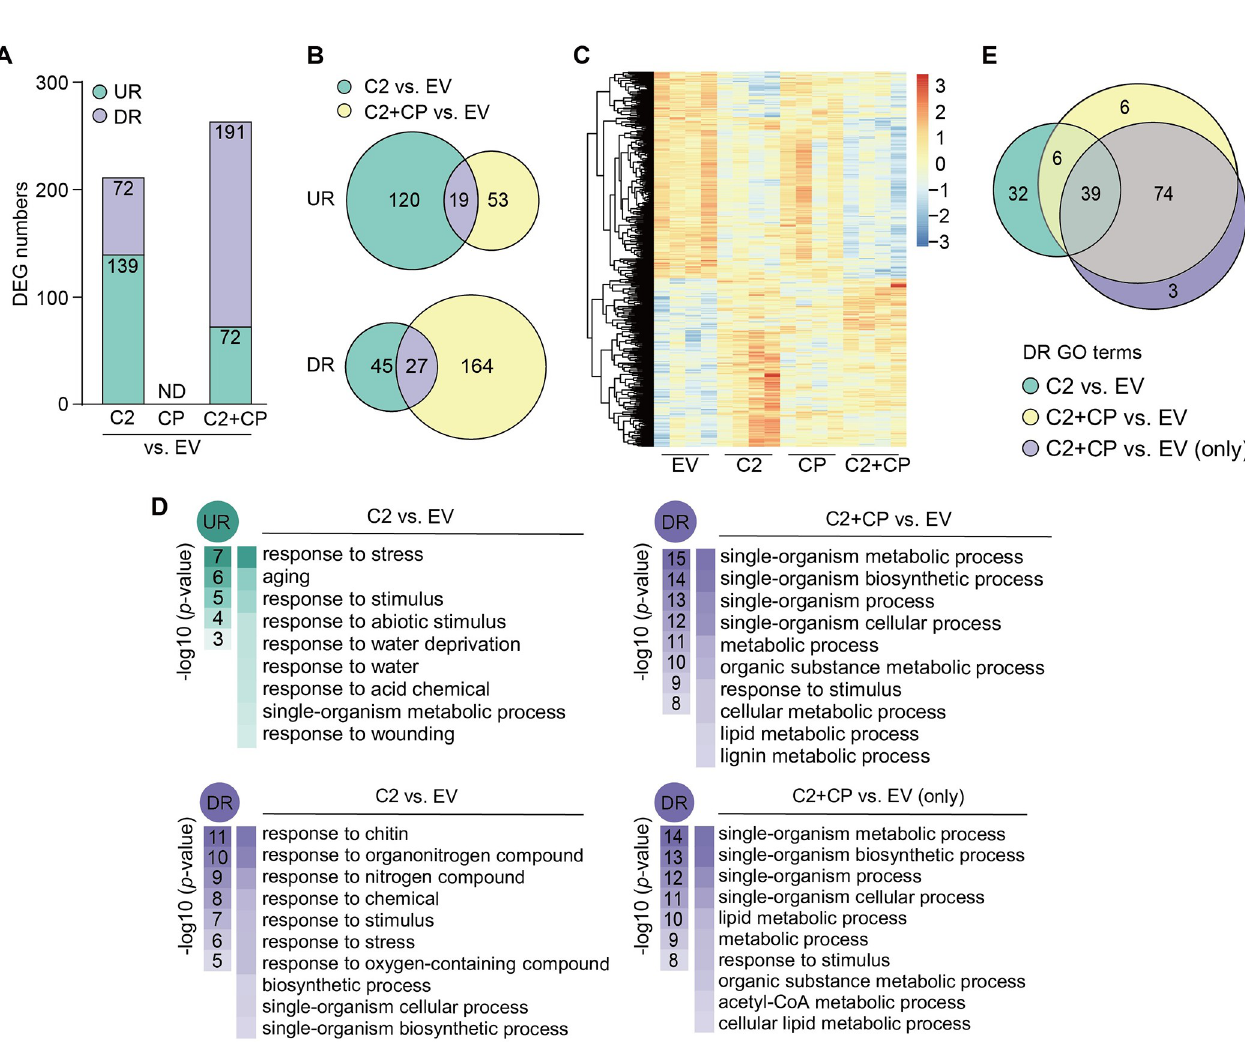
Fig 4. C2 and CP functionally interact in planta and modify the transcriptome of N . benthamiana in an interdependent manner. (A) Number of differentially expressed genes (DEGs) upon expression of C2, CP, or C2+CP in N . benthamiana leaves. UR: up-regulated; DR: down-regulated; ND: not detected; EV: empty vector. Full lists can be found in S2 Table. (B) Venn diagram of DEGs upon expression of C2 or C2+CP in N . benthamiana . UR: up- regulated; DR: down-regulated; EV: empty vector. (C) Heatmap with hierarchical clustering from samples in (A) . The colour scale indicates the Z-score. EV: empty vector. (D) Functional enrichment analysis of up-regulated (UR) or down-regulated (DR) genes in the indicated samples. Gene Ontology (GO) categories from the Biological Process ontology enriched with a p- value < 0.01 (up to top 10) are shown; functional enrichment was performed using the orthologues in Arabidopsis thaliana . “C2+CP vs. EV (only)” denotes the subset of genes that are down-regulated in this sample only, and not in the samples expressing the viral proteins separately. The colour scale indicates the -log10 ( p -value), showing the significance of GO term enrichment. EV: empty vector. For a full list, see S3 Table. (E) Venn diagram of the GO terms (Biological Process ontology) over-represented in the subsets of down-regulated genes ( p - value < 0.01) in the different samples. DR: down-regulated; EV: empty vector. For a full list, see S3 Table. See also S7 Fig; S2 and S3 Tables.